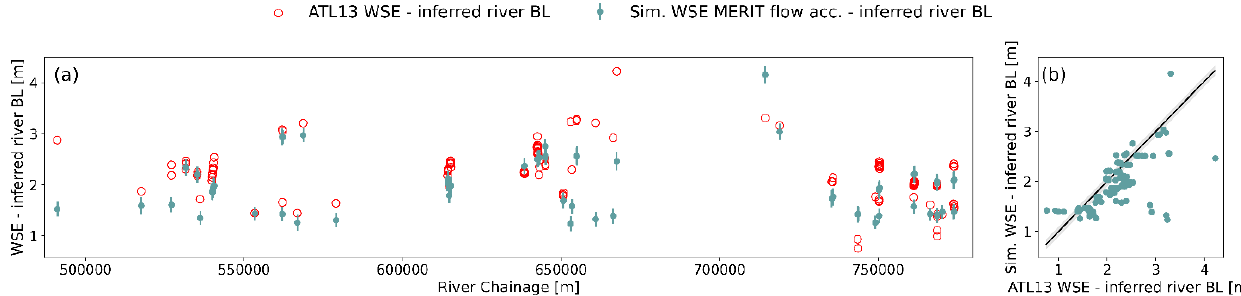
Figure 9. (a) Validation longitudinal profile using the steady-state solver for uniform depth and the MERIT flow accumulation between Jimai and Mentang. (b) Simulated vs. ATL13 WSE minus inferred BL. The shaded area corresponds to the mean standard deviation in the ATL13 product, as extracted from the flag stdev_water_surf.